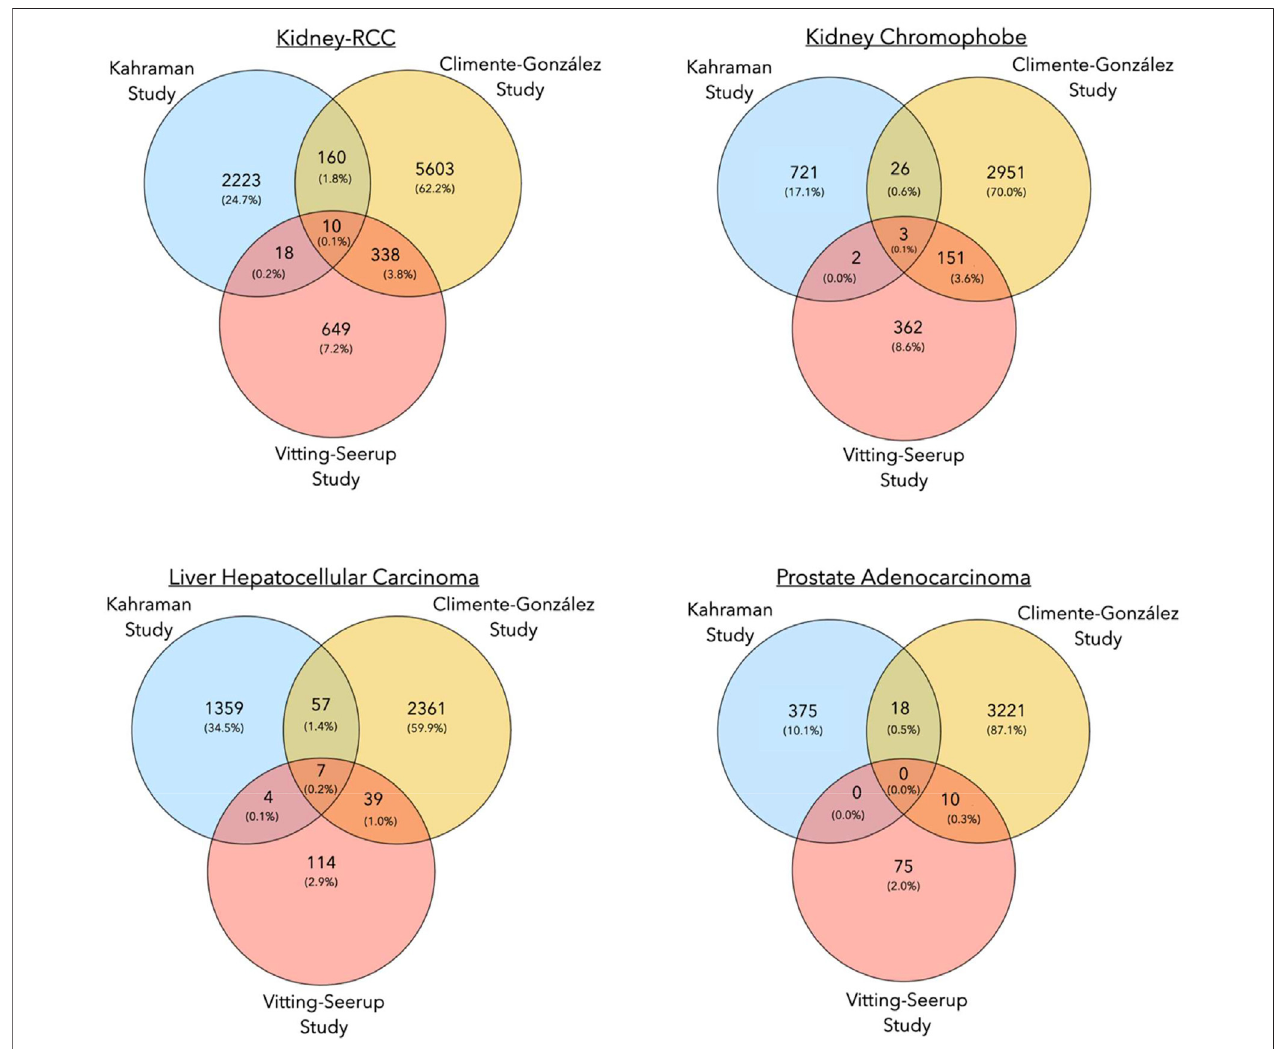
FIGURE 3 | Venn diagrams showing the number of common isoform switching events in three pan-cancer studies for Kidney-RCC, kidney chromophobe, liver hepatocellular carcinoma and, prostate adenocarcinoma.